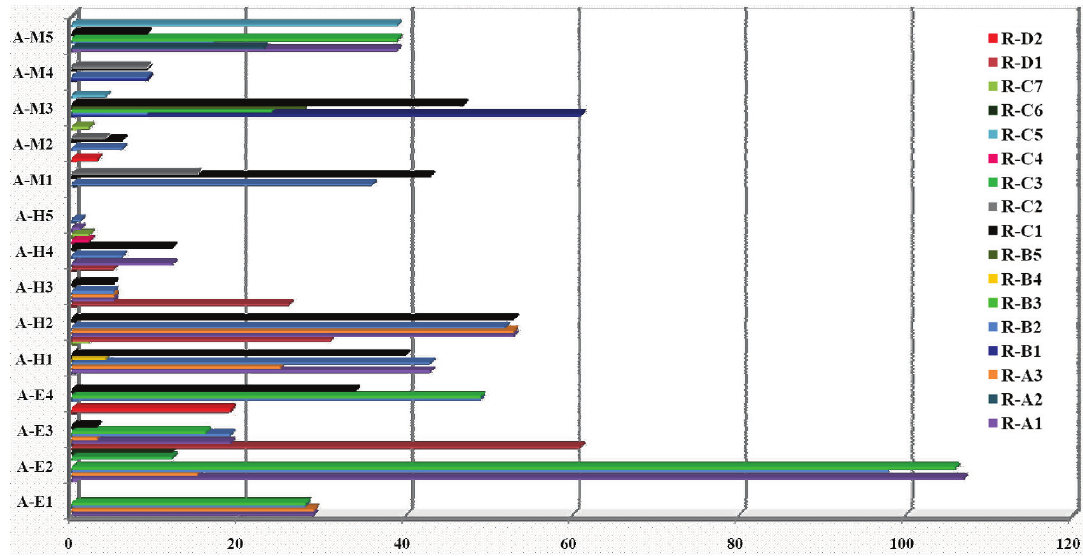
Fig. 10. Absolute frequency of each repair technique as a function of the anomaly